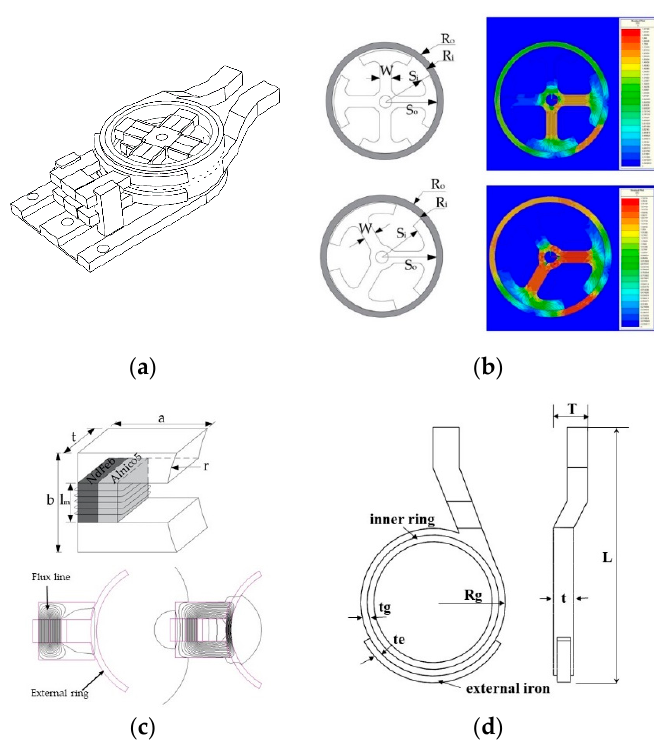
Figure 6. A proposed external fixed gripper: ( a ) Schematic of the proposed external fixed gripper; ( b ) The magnetic flux density distribution of three poles and four poles; ( c ) Proposed EM for the fixing wobble motor; ( d ) Schematic of the proposed gripper.